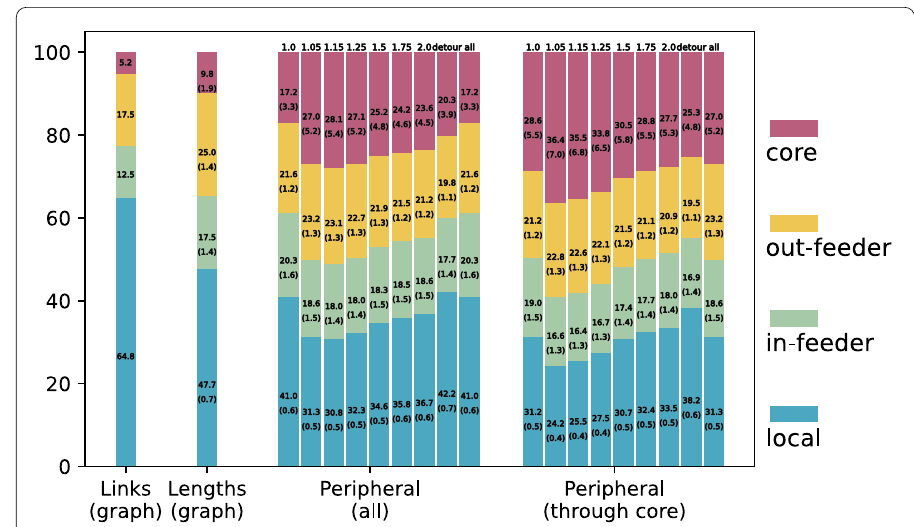
Figure 12 Percentage of edges and shipping length by edge type for various values of distance threshold α , the detour factor threshold (“detour”), as well as using the entire set of minimum-route paths (“all”). As in Fig. 8, numbers in parentheses correspond to length-to-edge percentage ratios. Results are similar for paths between all peripheral ports and paths between peripheral ports that include at least one core edge, and results are broadly similar across threshold values. Looking at all of the paths between peripheral ports, when only the minimum shipping distance path is kept ( α = 1.0), core edges account for about 17.1% of the total length, but after adding a small number of paths close to the minimum distance ( α = 1.05) the involvement of the core increases to 26.8%. As α increases, the percentage of core edges varies between 23.6% and 28.1%, while the detour threshold percentage is 20.3%. Turning to the paths between peripheral ports that pass through the core, at α = 1.0 core edges account for about 28.5% of the total length, but at α = 1.05 the involvement of the core increases to 35.9%. As α grows and fewer paths are filtered, the length percentage accounted for by the core decreases to 26.1% when all minimum-route paths are included, and is 25.3% using detour factor